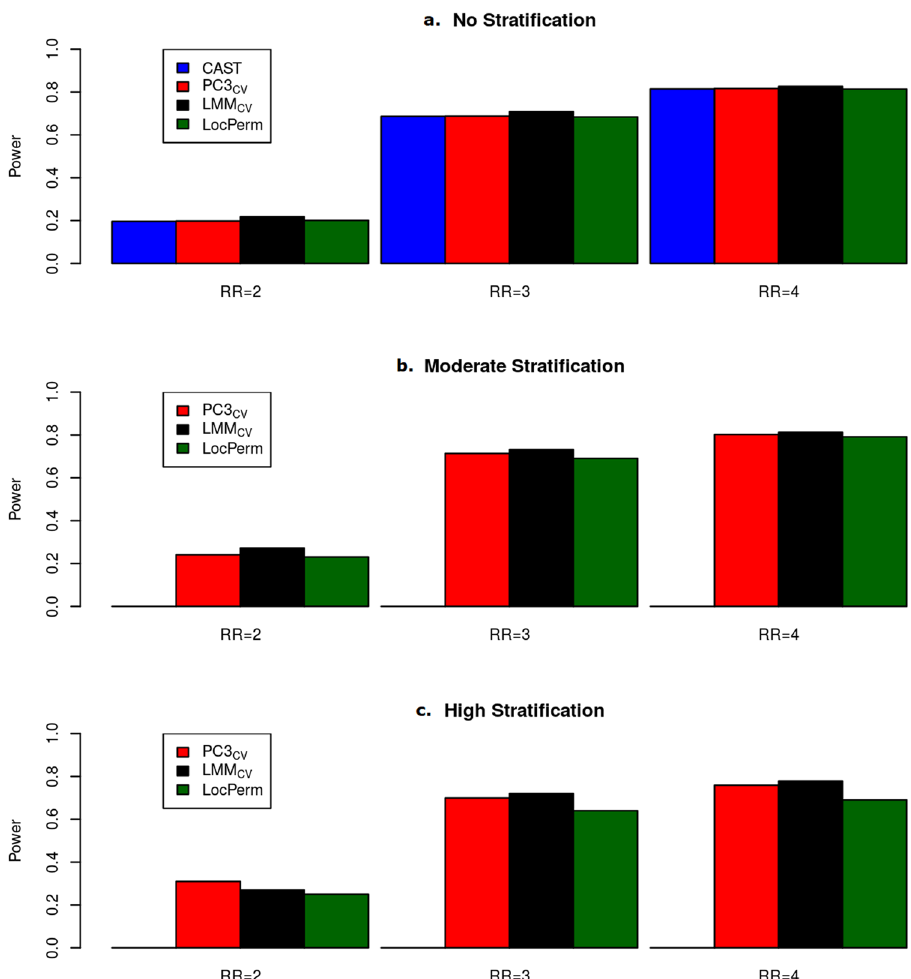
Figure 4. Histogram of powers for methods with a correct type I error rate for the large size Worldwide sample (n = 1967) at the level α = 0.001 . ( a ) Without stratification. ( b ) With moderate stratification. ( c ) With high stratification. Relative risks considered vary from 2 to 4 on the x-axis.